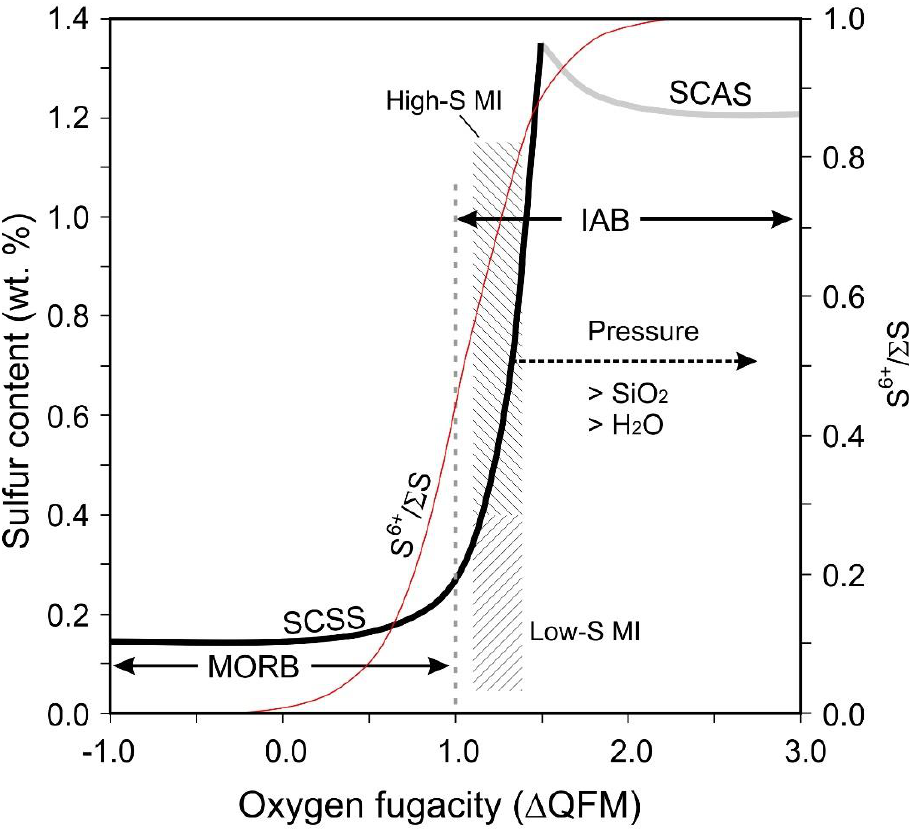
Figure 12. Saturation concentrations of sulfur in silicate melt over sulfide and anhydrite, depending on oxygen fugacity. The section of the sulfide saturation curve (SCSS, sulfur content at sulfide saturation) corresponds to f O 2 < QFM + 1.5. For more oxidized melts, the maximum sulfur concentration (SCAS, sulfur content at anhydrite saturation) is determined by the crystallization of magmatic anhydrite from the melt. The maximum possible sulfur concentration in the melt corresponds to the value f O 2 = QFM + 1.5. At this value, the SCSS and SCAS curves intersect. The f O 2 and sulfur contents for Tolbachik melt inclusions (high-S MI and low-S MI) are shown by hatching. Thesulfur speciation curve S6+/ S vs. f O 2 is also shown. Modified from [40].